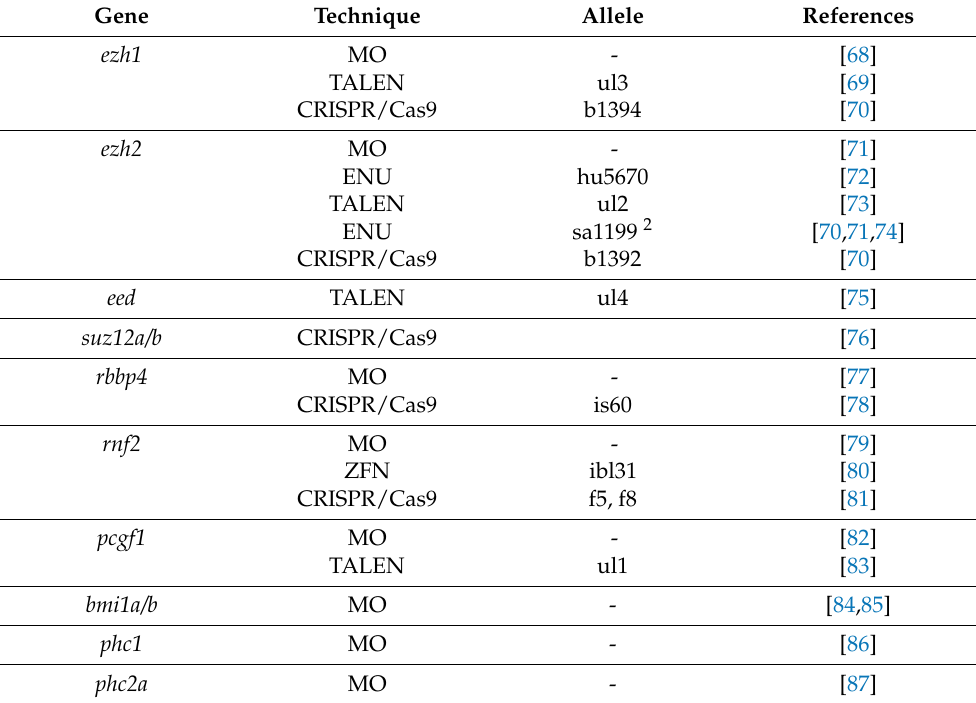
Table 4. Genetic studies of zebrafish genes coding for PRC1 and PRC2 components. Gene Technique